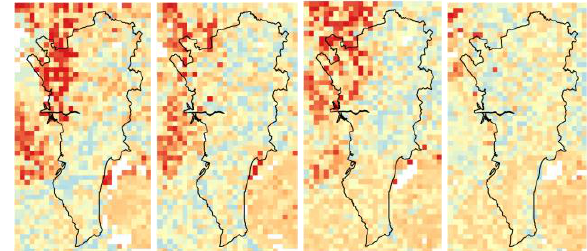
Figure 13. Sample PM 2.5 estimation maps using the best dry model for March 2017 to 2020.